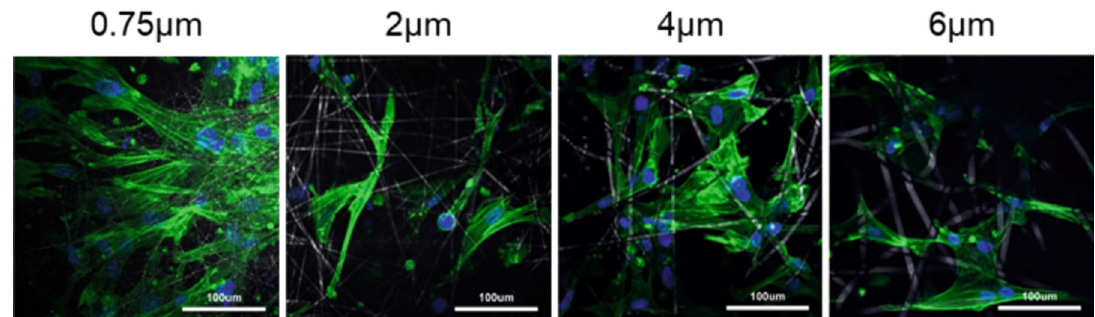
Fig. 3 2D confocal fl uorescent images of nuclei (DAPI — blue) and Actin (phalloidin — green) stained HUVSCMs on all four scaffold morphologies